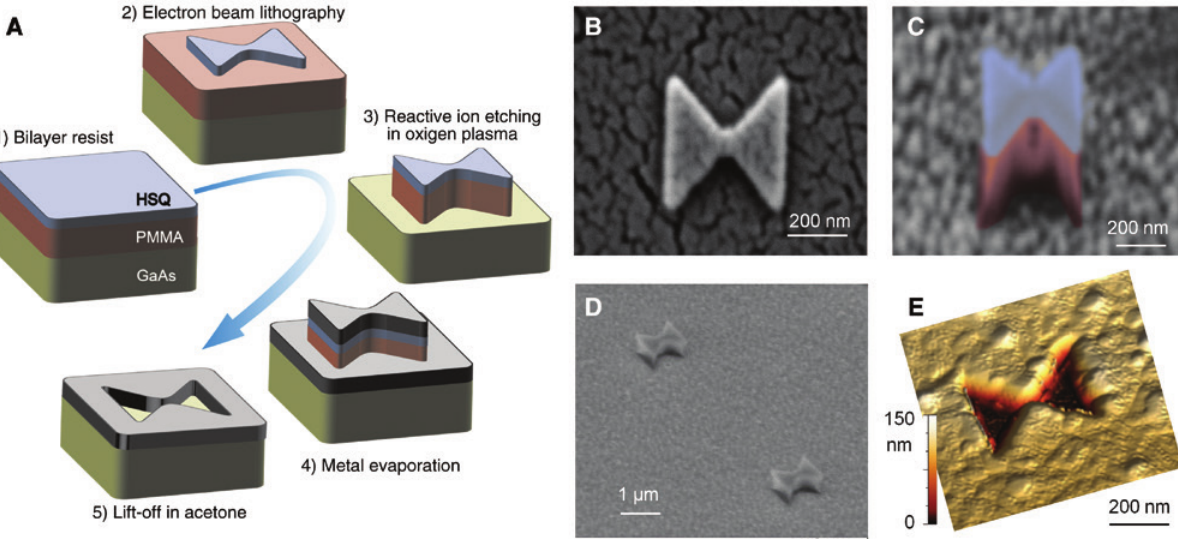
Figure 2: Bowtie NA